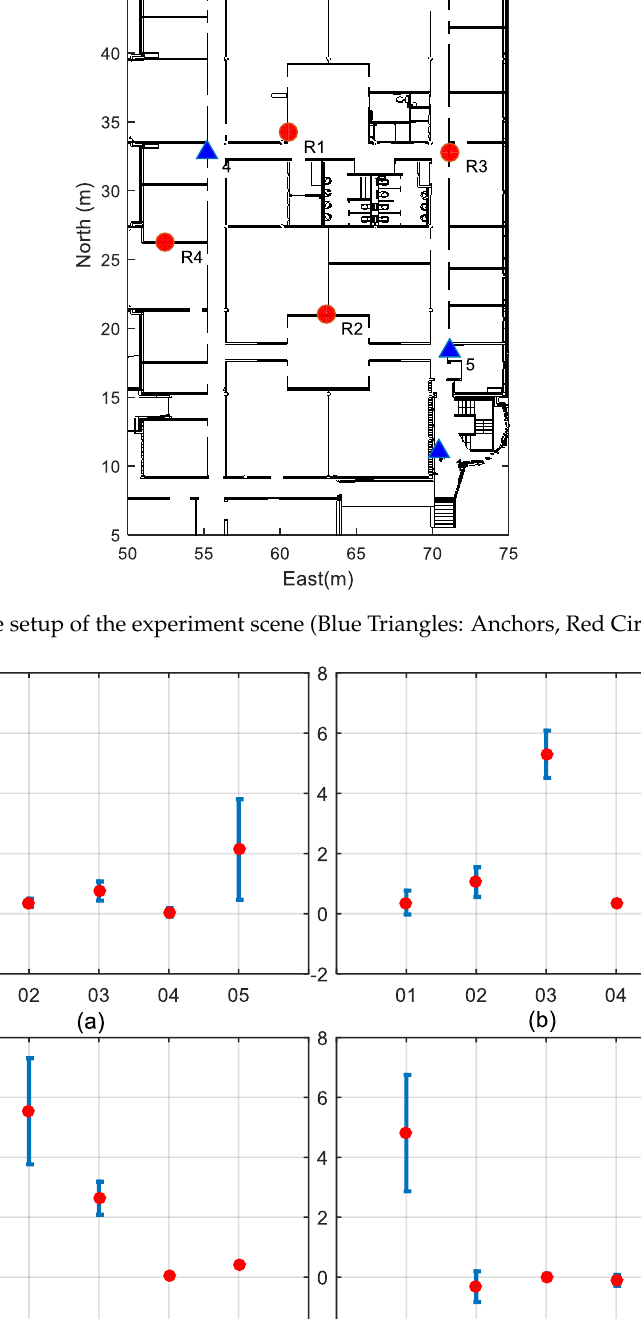
Figure 16. The mean value (red dots) and standard deviation (blue bar) of the TOA residuals subject to the truth. (a):MS 1 (b):MS 2 (c):MS 3 (d):MS 4.